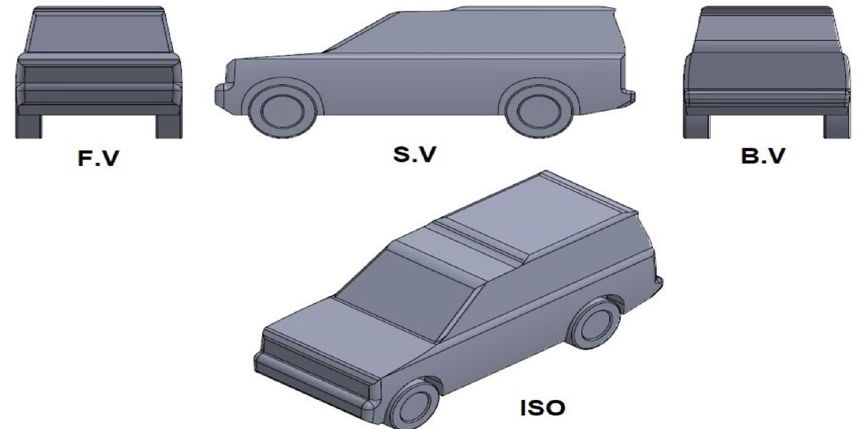
Figure 1. The benchmark of the